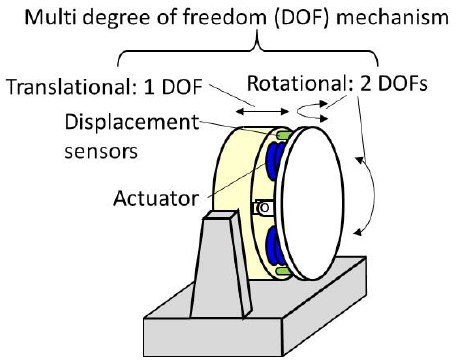
Figure 2. A fast steering mirror (FSM) having a multi-degree-of-freedom (DOF) mechanism. The rotational motion is for jitter compensation. The translational motion is for defocus correction.